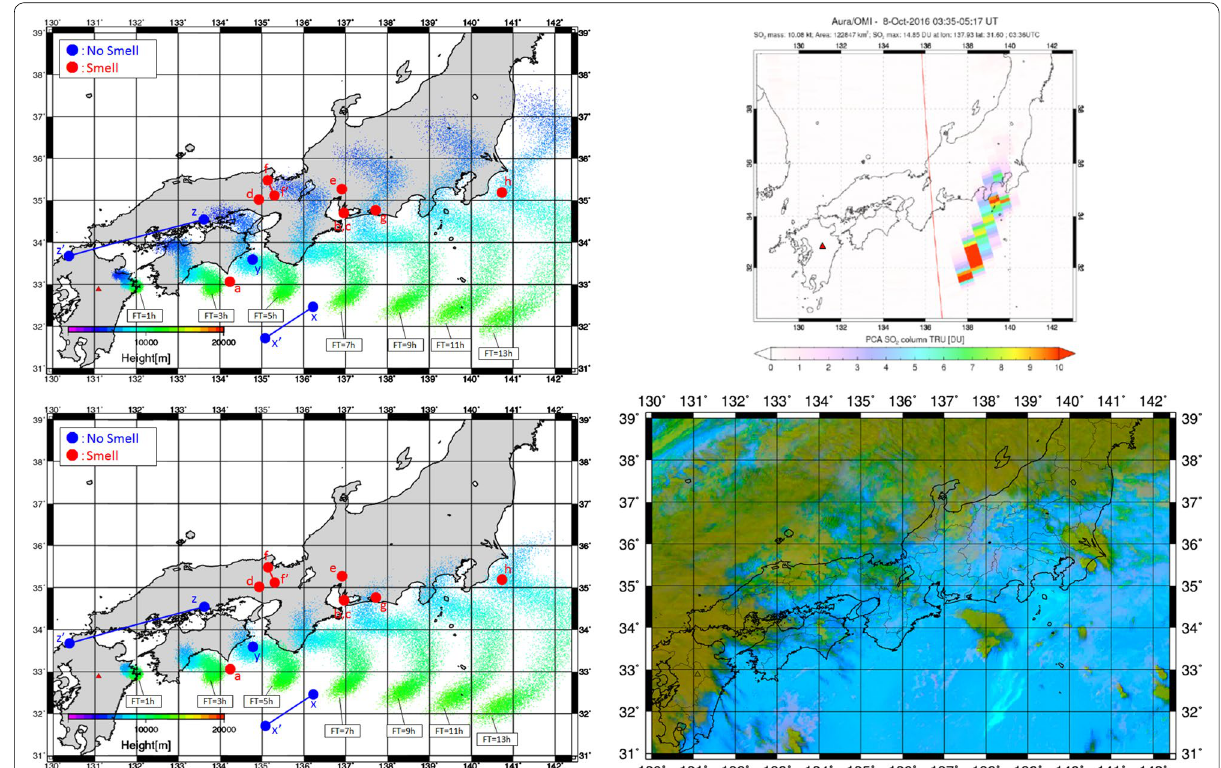
Fig. 5 The two left figures are the time series (FT 1(02:46JST)-FT13(14:46JST)) of the JMA-GATM simulations and pilots’ reports. (The upper figure = is the result from an initial altitude of SO 2 at 5–14 km. The bottom figure is the result from an initial altitude of SO 2 at 7–14 km.) The lettered points are pilots’ reports including “VA SMELL” or “SULFUR” as follows: a;06:00JST(FL270–320), b;09:16JST(FL210), c;09:34JST(FL210–240), d;09:50JST(FL180), e;10:20JST(FL190), ff’;10:28JST(FL090), g;10:39JST(FL290), h;13:32JST(FL090–100), xx’;06:08JST(FL370–390), y;08:31JST(FL170), zz’;10:40JST(FL360). FL is flight level (FL100 10,000 feet). The right upper figure is SO 2 observation from Aura/OMI, 00:35–02:17JST (NASA-GFSC et al. 2016). The right bot- = tom figure is the Ash RGB at